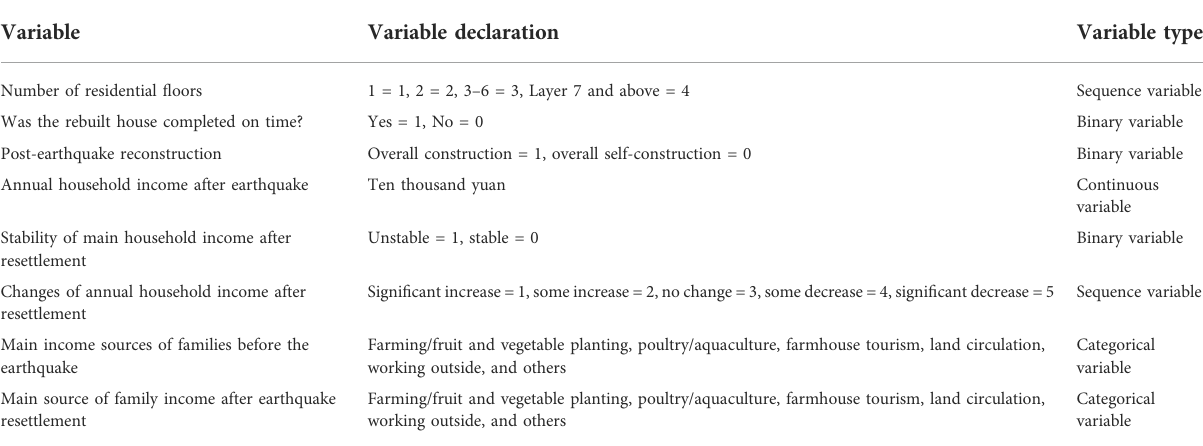
TABLE 2 Description of respondents ’ family